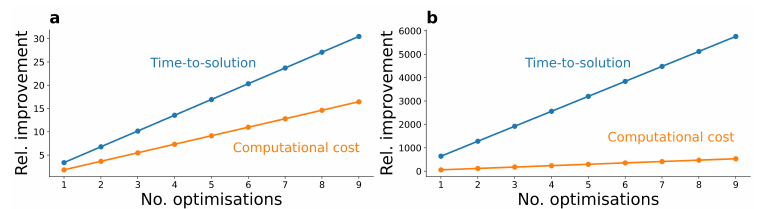
Figure A3. Relative improvement in terms of time-to-solution and computational cost for the AWA ( a ) and the IsoDAR ( b ) optimisations. The curves are calculated analytically based on measurements of the prediction time for the surrogate model and